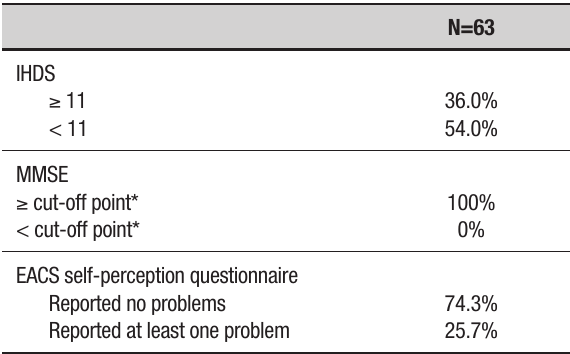
Table 2. Performance of HIV-infected patients on different neurocogni- tive assessment